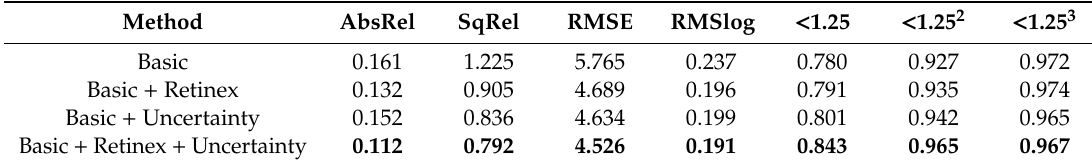
Table 2. Ablation study (Input image resolution: 416 × 128).